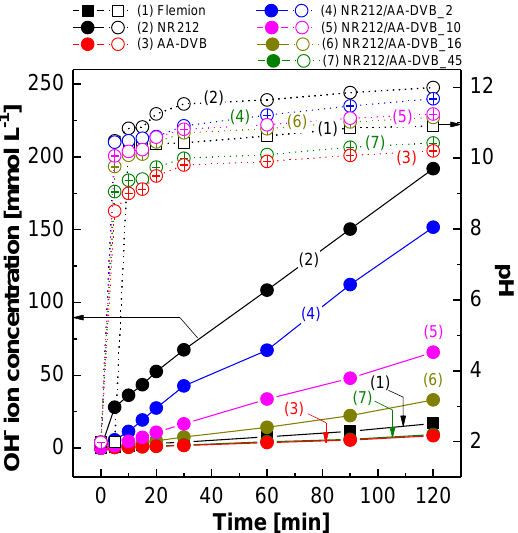
Figure 7. OH − di ff usion behavior of NR212 / AA-DVB membranes over time. Figure 7. OH − diffusion behavior of NR212/AA-DVB membranes over time.